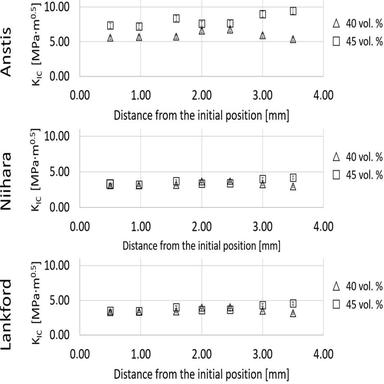
Fracture strength of sintered samples with different solid content prepared with CSC method, calculated with different equations.